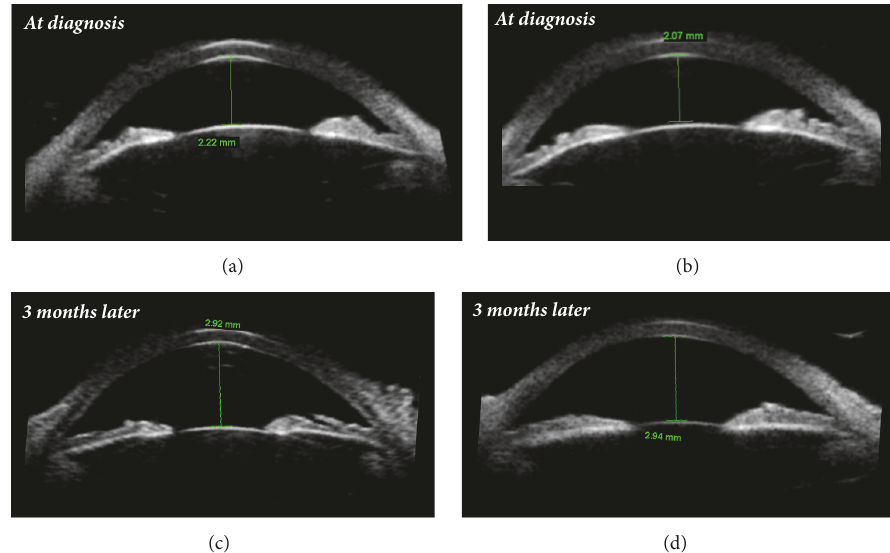
Figure 2: Ultrasound biomicroscopy showing shallow anterior chamber at diagnosis ((a) right eye, with anterior chamber depth of 2.22 mm; (b) left eye, with anterior chamber depth of 2.07 mm), and deepening of the anterior chamber three months later ((c) right eye, with anterior chamber depth of 2.92 mm; (d) left eye, with anterior chamber depth of 2.94 mm).